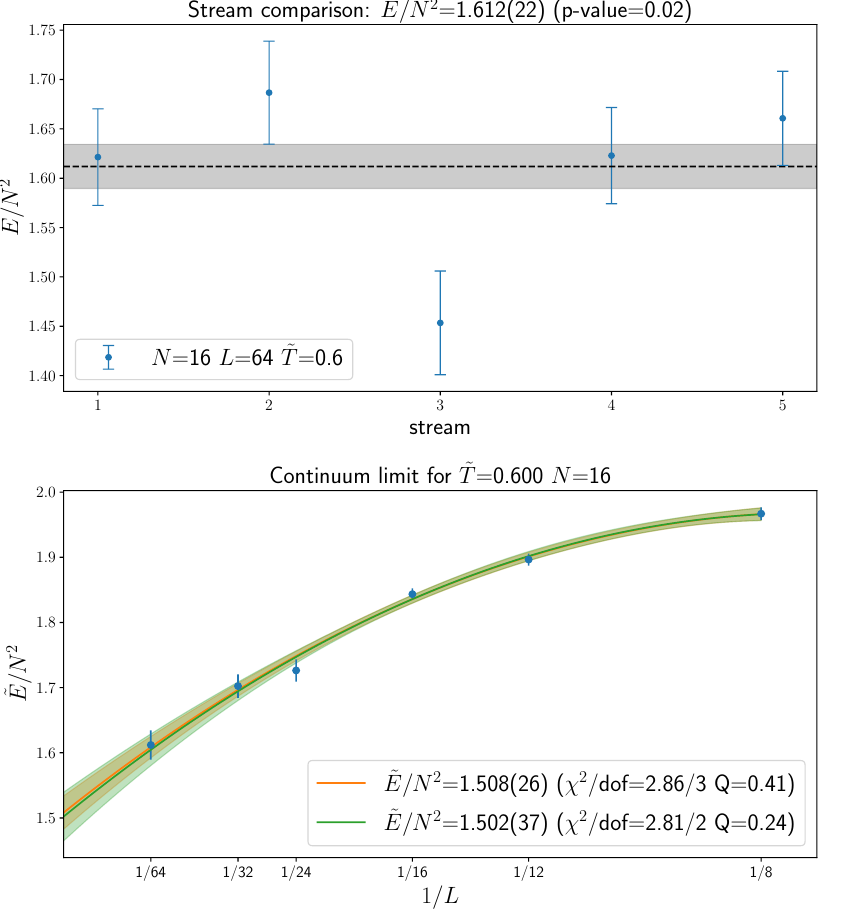
Figure 11. [Upper] Weighted average of (cid:12)ve independent streams at N = 16, L = 64 and ~ T = 0 : 6. One of the streams is more than two standard deviations away from the weighted average over the di(cid:11)erent streams. [Lower] Continuum (cid:12)t at N = 16 and ~ T = 0 : 6 with and without the L = 64 point. The results are indistinguishable. (The legend reports the internal energy value in the continuum and the (cid:31) 2 /dof and Q-value of the (cid:12)t.)